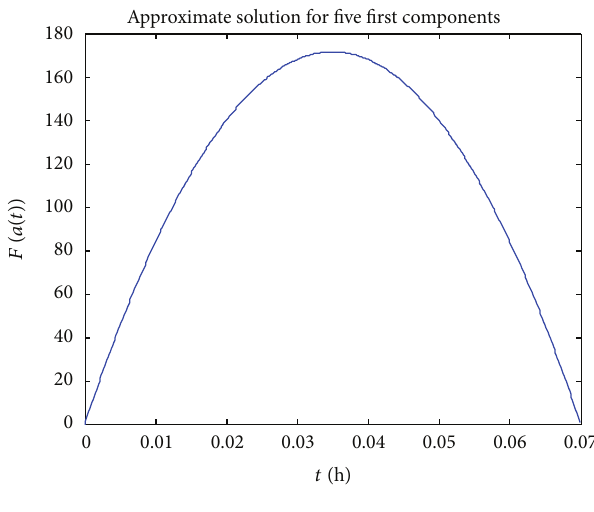
Figure 5: Surface showing the approximate solution of the govern- ing differential equation in the elastic indentation phase equation (21) for 𝛽 = 1.9 .